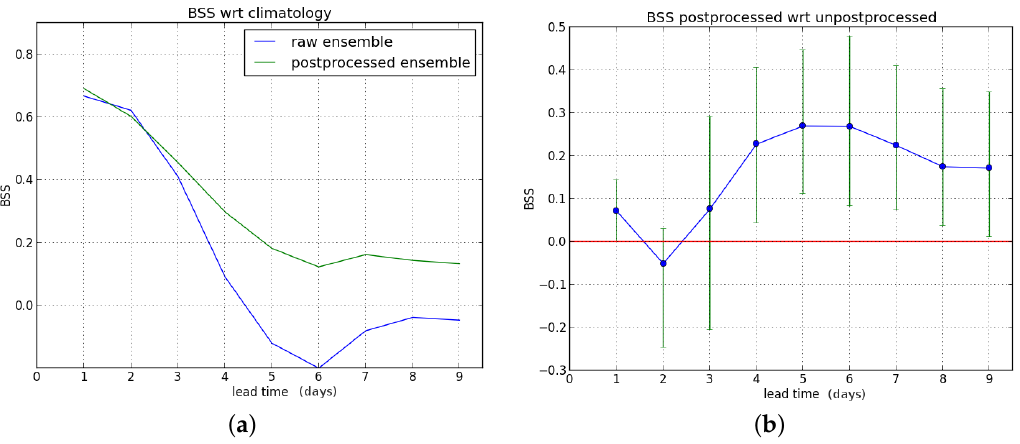
Figure 9. Brier Skill Score for the P90 threshold. Comparison with reference discharge, hydrological summer. ( a ) Compared to sample climatology; ( b ) Improvement due to postprocessing.